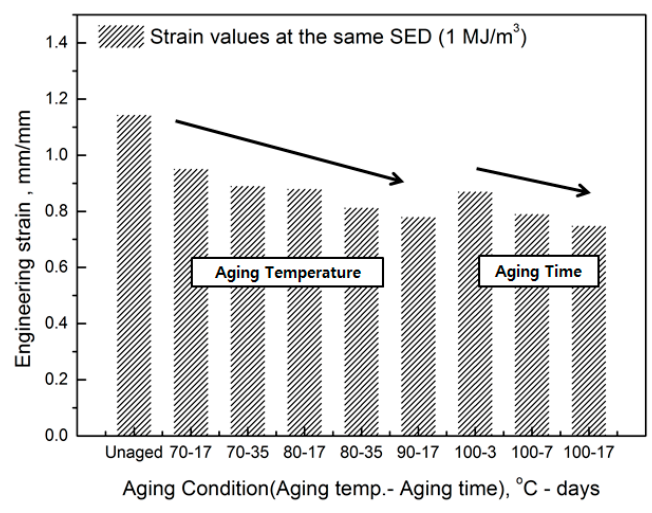
Figure 5. Decrease in strain on aging.